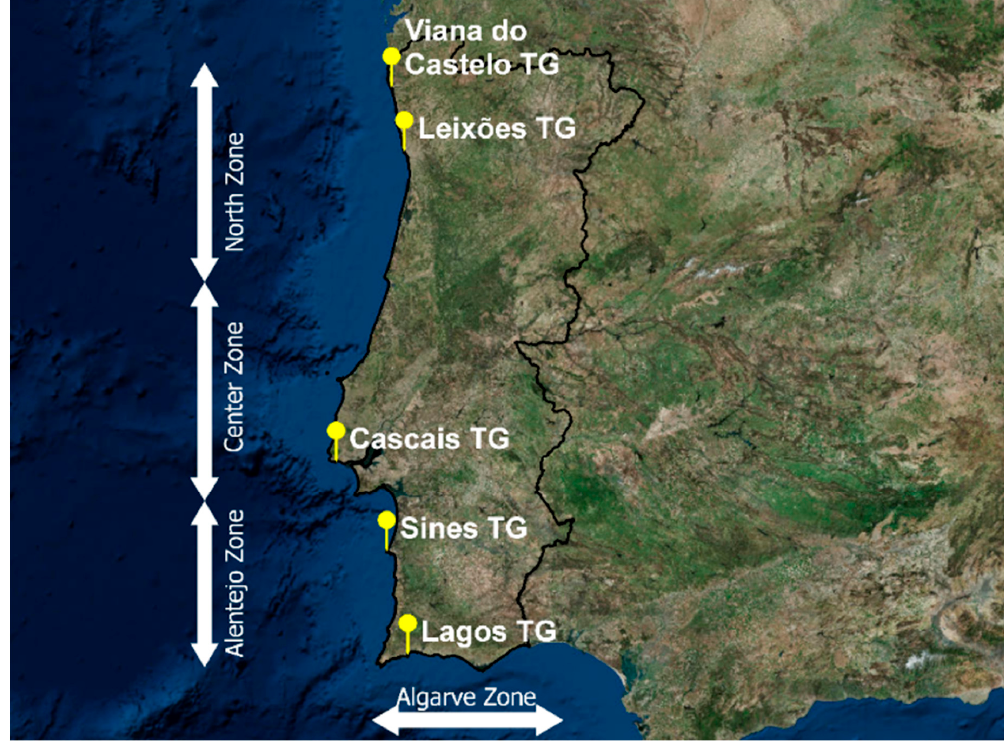
Figure 2. Location of the five tide gauges (TGs) used in the study: Leix õ es, Cascais, Sines, and Lagos for the tide modeling and Viana do Castelo for storm surge analysis in the northern